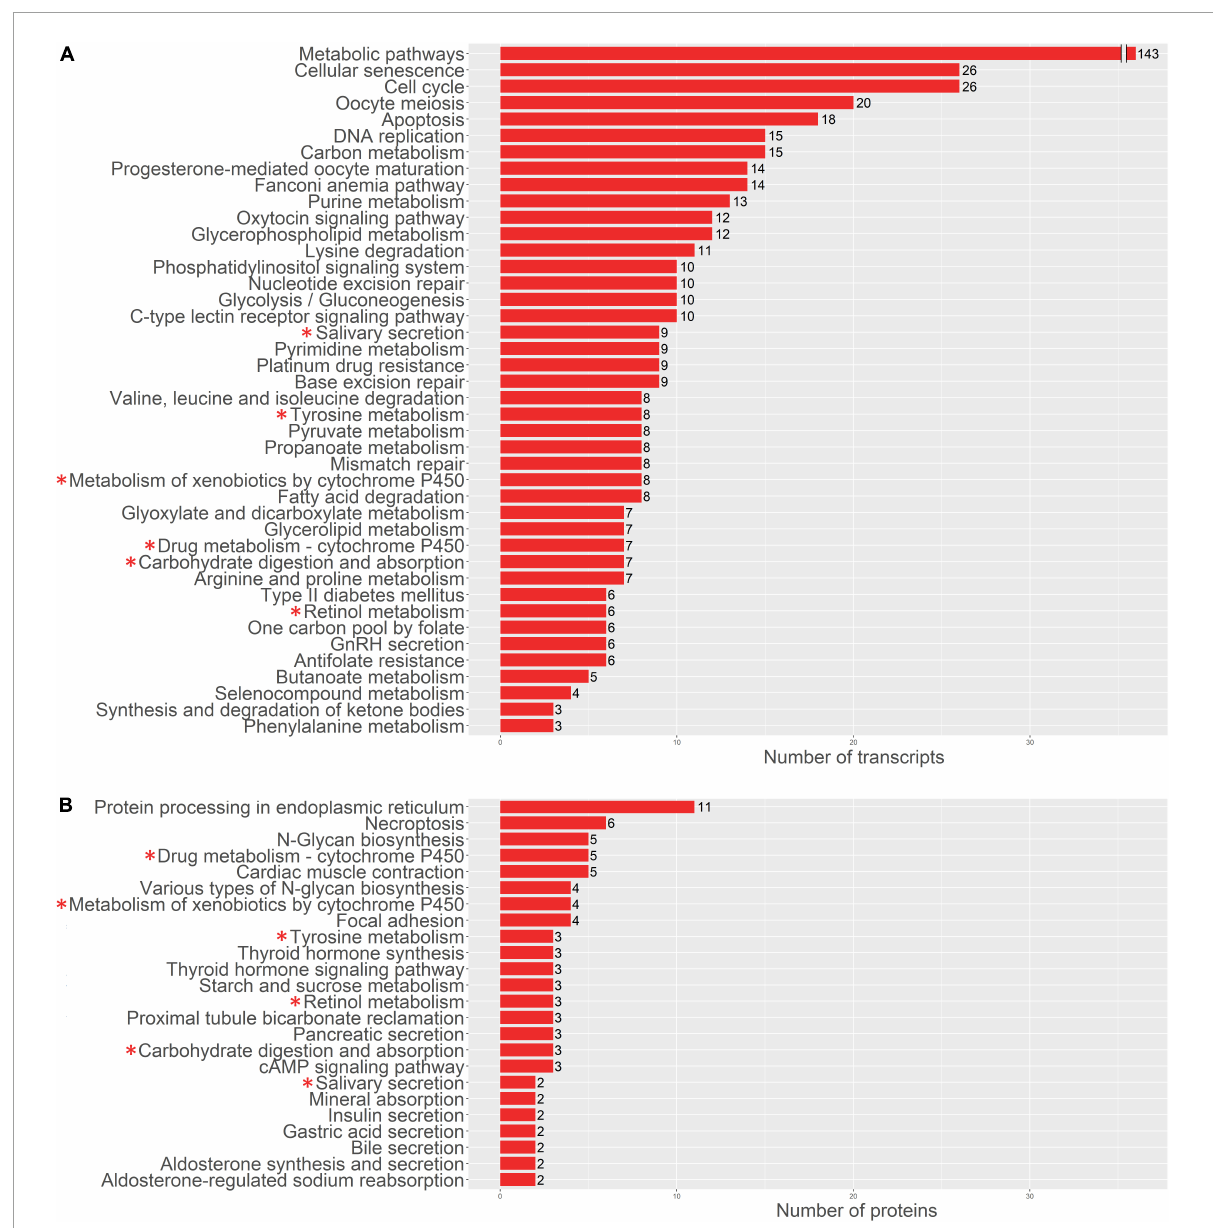
FIGURE3 Pathway enrichment analysis of upregulated genes involved in osteogenic differentiation of human aortic valve interstitial cells (VIC) by KEGG: biological processes database. Abscissa axis represents biological processes associated with VIC osteogenic differentiation in early timepoint by RNA-seq transcriptomics data (A) or later timepoint by shotgun proteomics data (B) ; ordinate axis represents number of identified differentially expressed transcripts (A) or proteins (B) enriched in corresponding biological process. Asterisk marked KEGG (*): biological processes enriched in both proteomics and transcriptomics